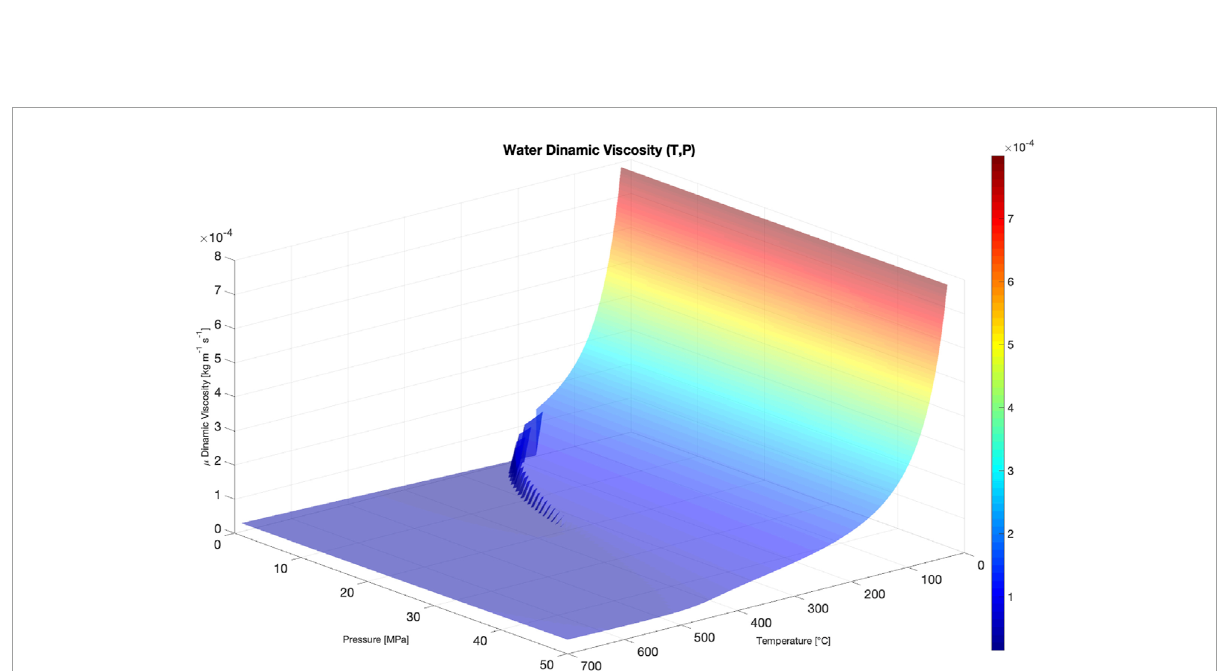
FIGURE 3 Schematic of a DBHE.